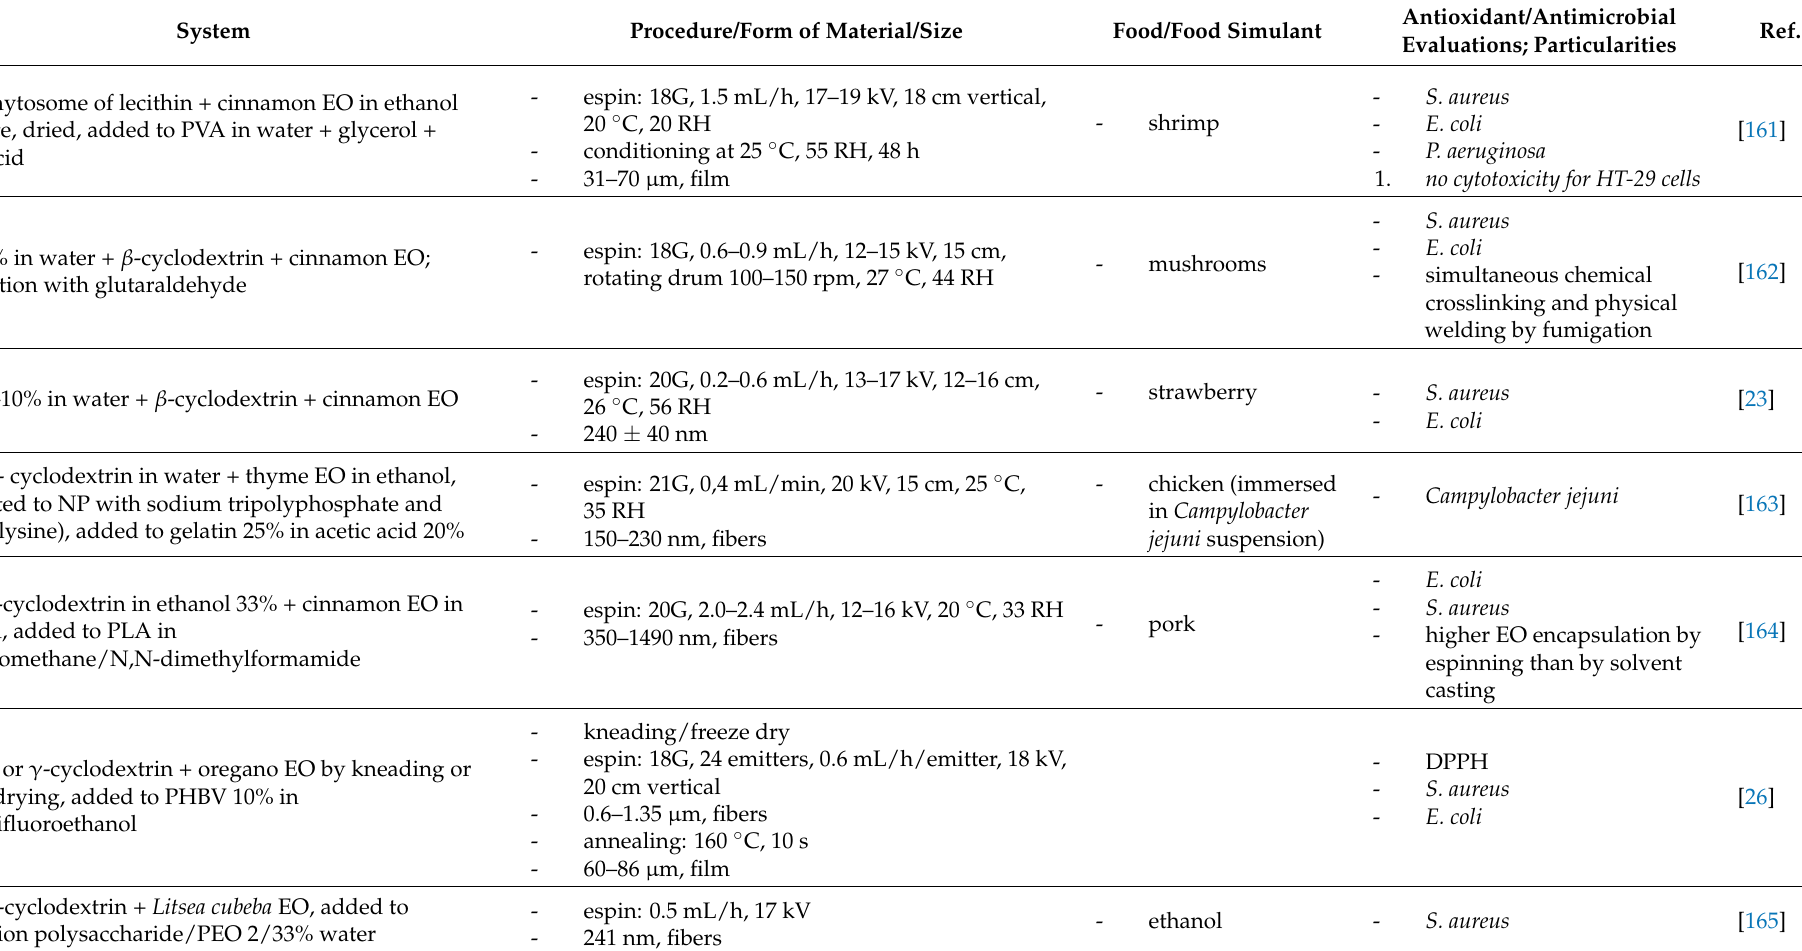
Table 2. Cont. Procedure/Form of Material/Size Food/Food Simulant